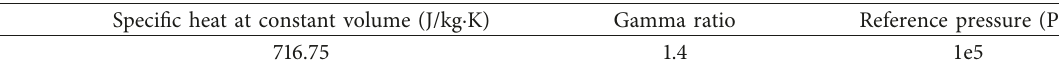
Table 2: Material properties for the ideal gas law for atmospheric